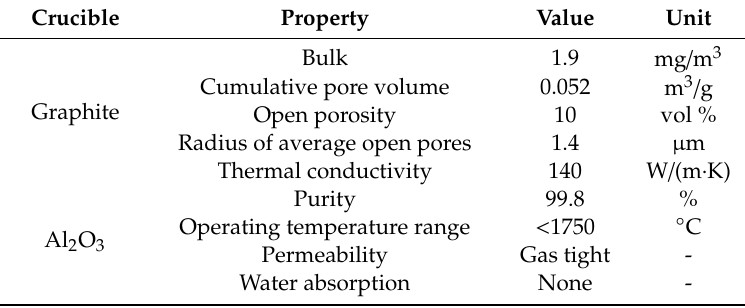
Table 3. The physical properties of the graphite and alumina crucibles.